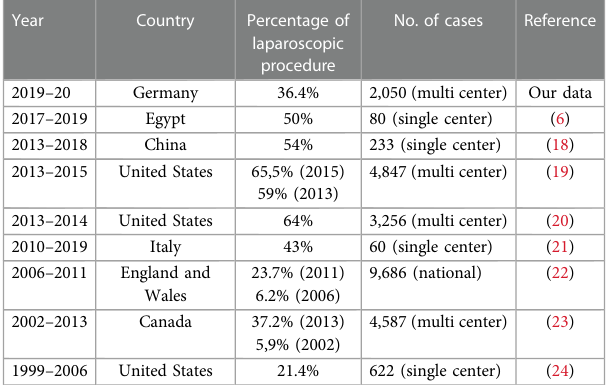
TABLE 5 Number of pyloromyotomies in literature compared to our